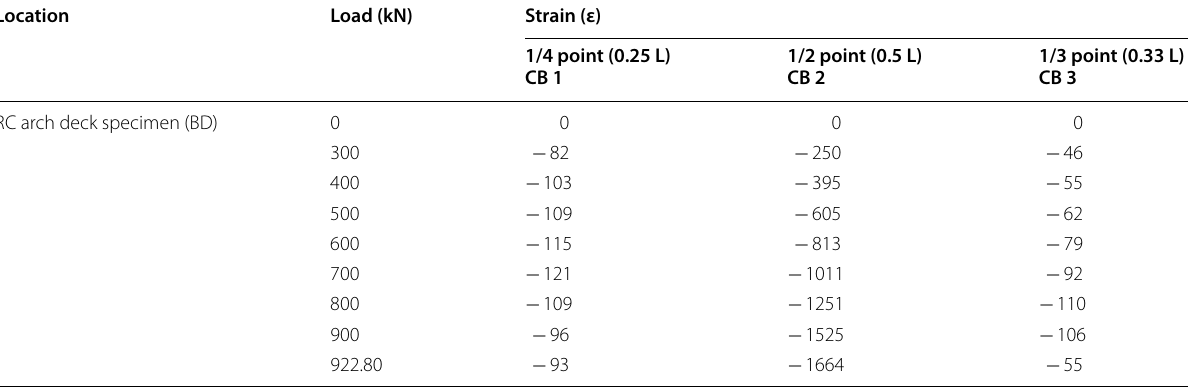
Table 10 Test results of load–concrete strain data